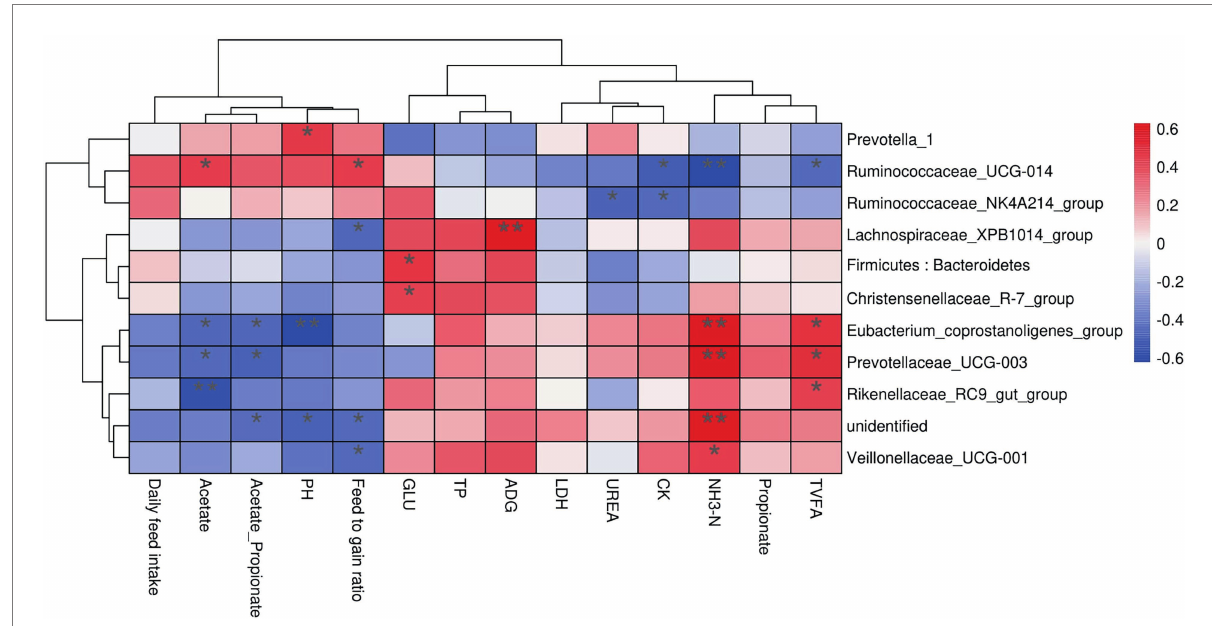
FIGURE 5 Analysis of LEfSe difference in KEGG metabolic pathway of rumen bacteria. HY, high ME:N (0.42 MJ/g); MY, medium ME:N (0.36 MJ/g); LY, low ME:N (0.32